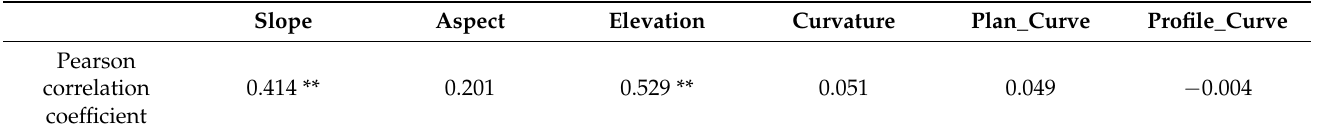
Table 8. Correlation coefficient matrix for terrain factor and